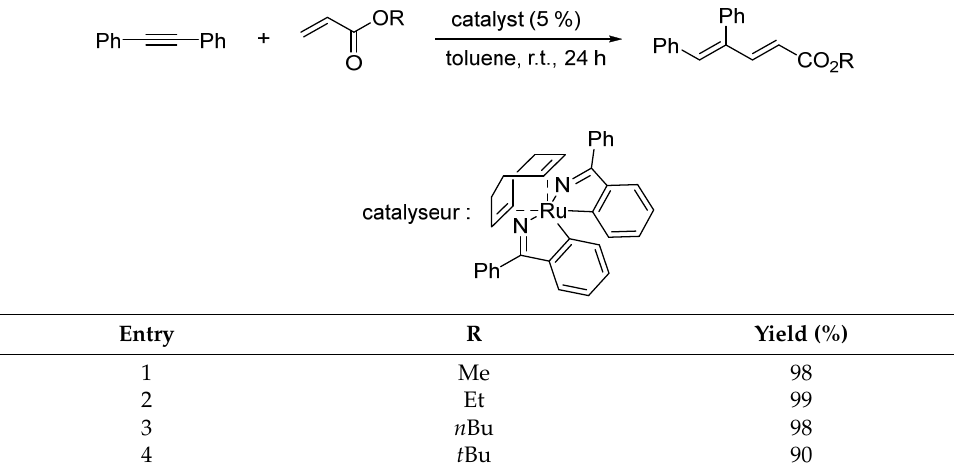
Table 6. Alkyne–acrylate coupling according to Zhao’s group.